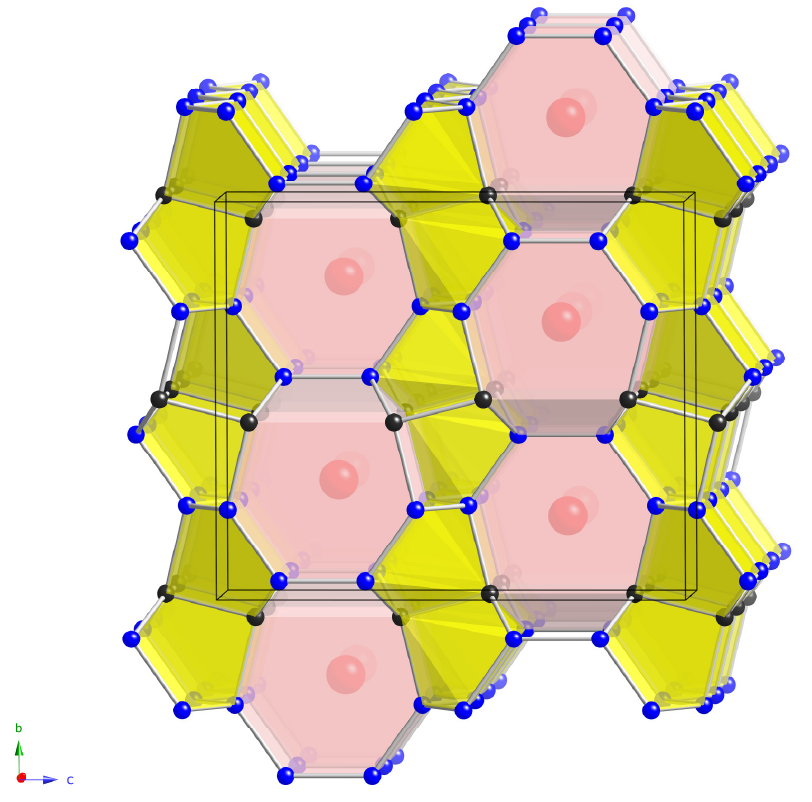
Figure 6. Polyhedral view of the orthorhombic crystal structure of BaGa residing in the (Ga,Sn) polyhedra are drawn as red spheres. The empty 9-atom voids are 18 shown in yellow. Sn1 atoms (8 f site, 100% occupancy by Sn) are shown as black spheres, while the remaining two framework sites with statistical mixtures of Sn/Ga atoms are represented as blue spheres,